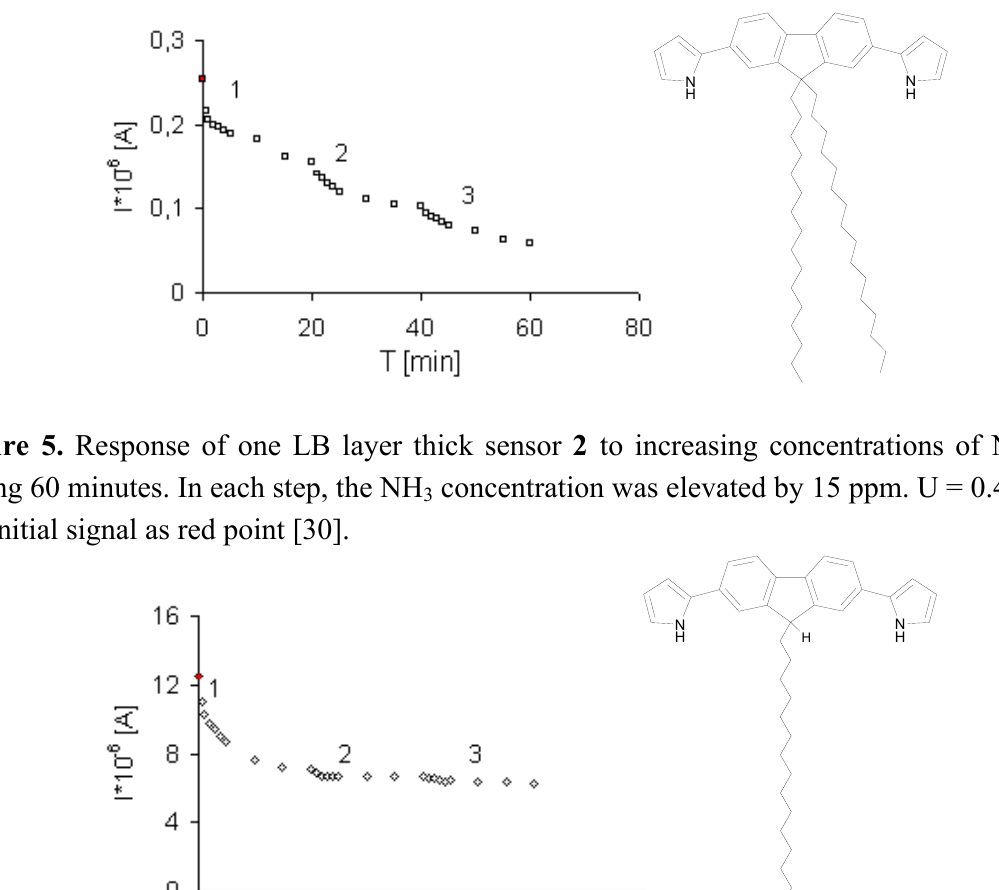
concentration was increased by 15 ppm. U = 0.5 V, 3